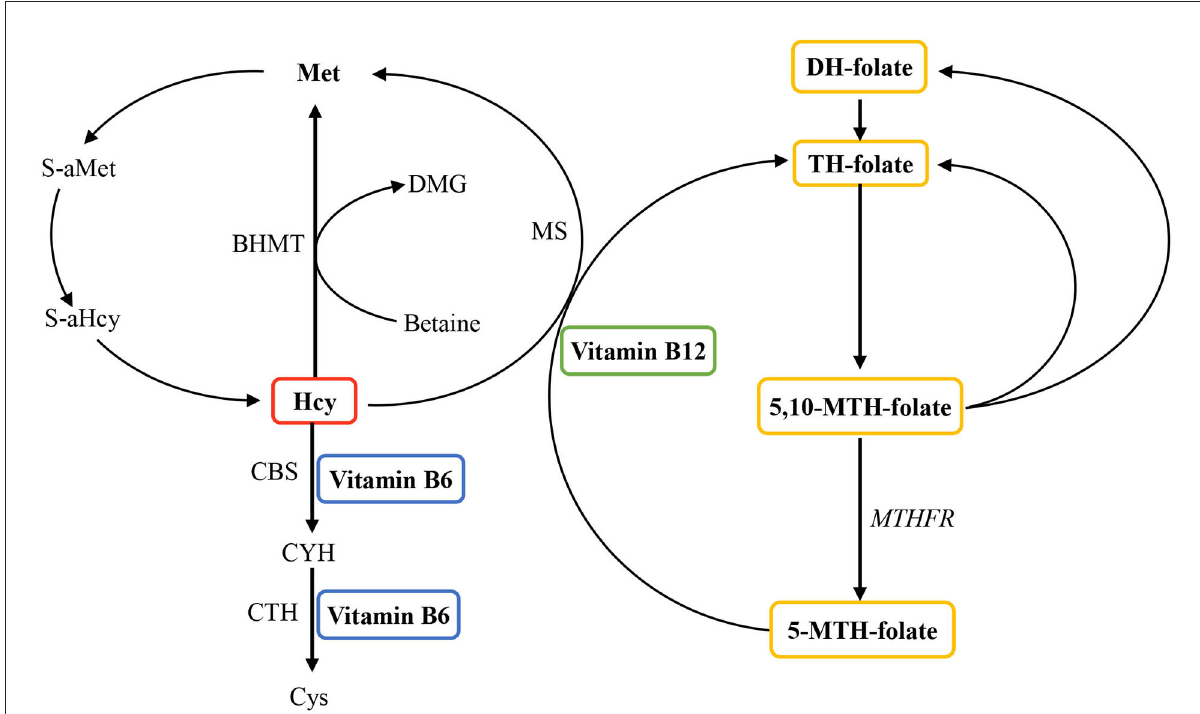
FIGURE1 Overview of the role of vitamin B6, vitamin B12, and folate in homocysteine metabolism. Homocysteine is reconverted to methionine by acquiring a methyl group from 5-methyltetrahydrofolate, the positive form of betaine or folate in the remethylation pathway. Irreversible removal of homocysteine happens across the transsulfuration pathway in which homocysteine condenses with serine to form cystathionine. BHMT, betaine homocysteine methyltransferase; CBS, cystathionine- β -synthase; CYH, cystathionine; CTH, cystathionine-gamma-ligase; Cys, cysteine; DH, dihydo; DMG, dimethylglycine; Hcy, homocysteine; Met, methionine; MS, methionine synthase (encoded by the MTR gene); MTH, methylenetetrahydrofolate; MTHFR, methylenetetrahydrofolate reductase; S-aMet, S-adenosylmethionine; S-aHcy, S-adenosylhomocysteine; TH,